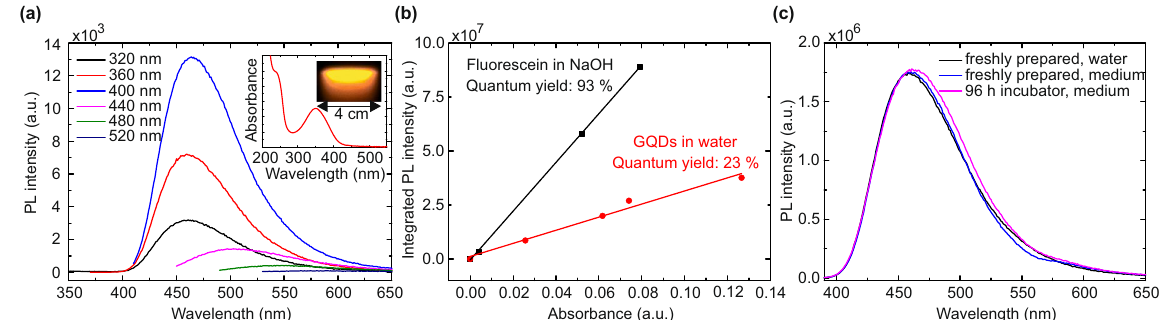
Figure 2. ( a ) Fluorescence spectra of the quantum dots as a function of the excitation wavelength. The corresponding absorbance spectrum including an image of the GQD solution under excitation with blue light is shown in the inset. ( b ) Integrated PL intensity vs. absorbance of fluorescein and GQDs to determine the GQD quantum yield of 23% at 360 nm excitation. ( c ) Comparison of the fluorescence spectrum of freshly prepared GQDs and GQDs stored for 96 h in the incubator in a humidified atmosphere at 5% CO 2 and 37 °C dissolved in cell culture medium at 360 nm